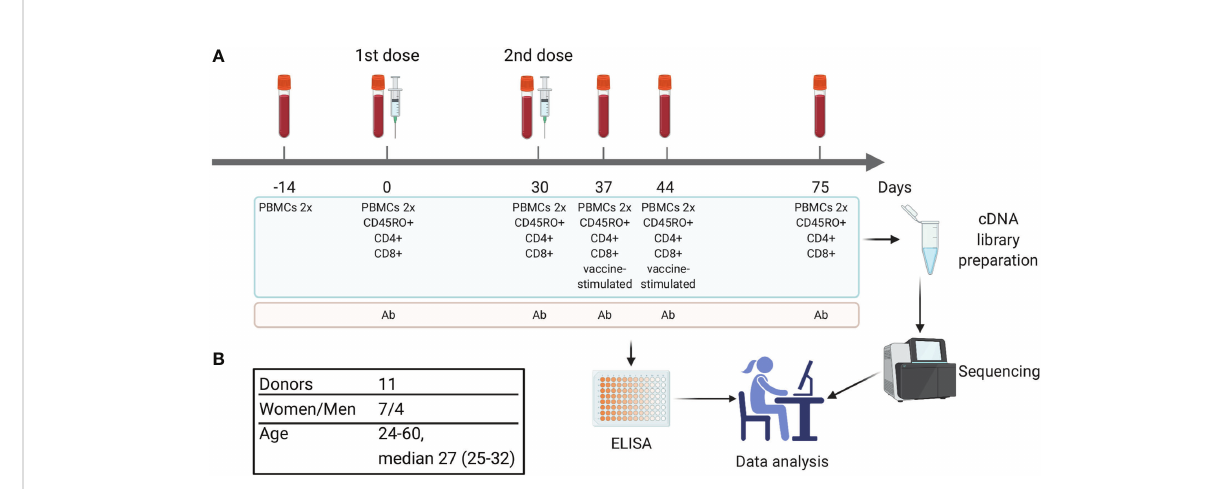
FIGURE 1 Study design. (A) Timeline of vaccination and blood sample collection. At each time point two replicates of bulk PBMCs were collected (PBMCs 2x). Additional aliquots of PBMCs were divided into cell subsets, including CD4 + , CD8 + , and CD45RO + (memory T cells). On days 37 and 44 a portion of PBMCs was used for in vitro stimulation with inactivated puri fi ed TBEV particles followed by isolation of CD137 + and IFN g -producing T cells. Blood serum was used for TBEV-speci fi c IgG antibody level measurement. (B) Donors cohort